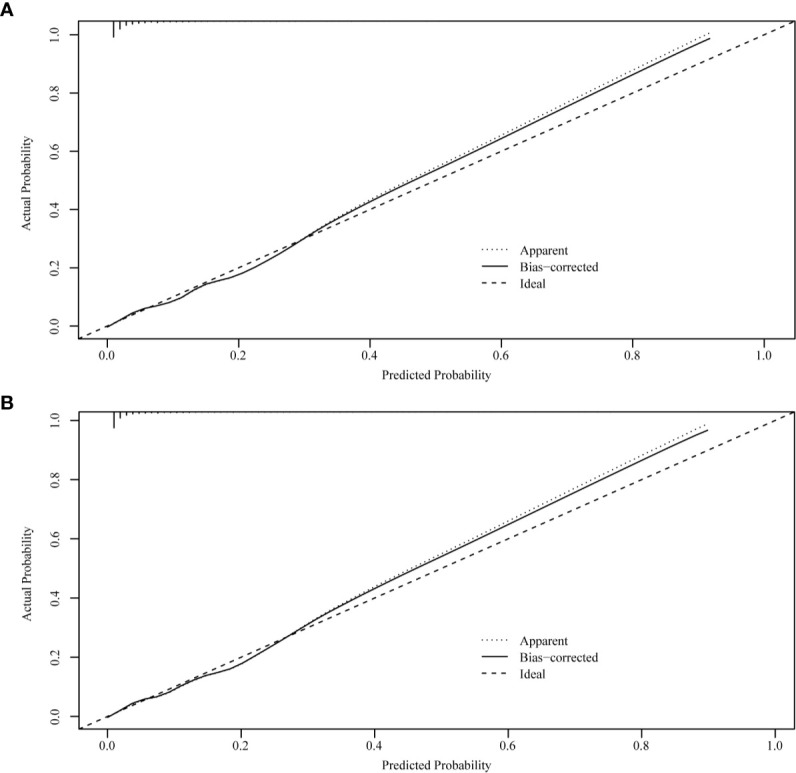
Internal verification plots of nomogram calibration curves by bootstrapping with 1,000 resamples. (A) The total early death; (B) The cancer-specific early death.